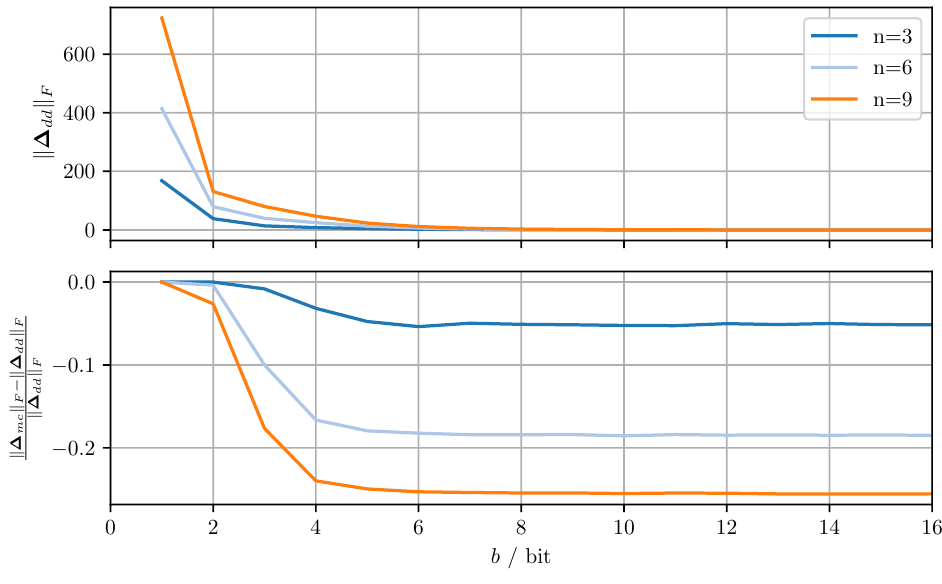
Figure 3. Average Frobenius norm of the quantization error matrix ∆ dd of the diagonal dominance- based quantization approach ( top ), and the relative improvement achieved by the modified Cholesky- based quantization approach ( bottom ) for varying dimensions n and bits per codeword b